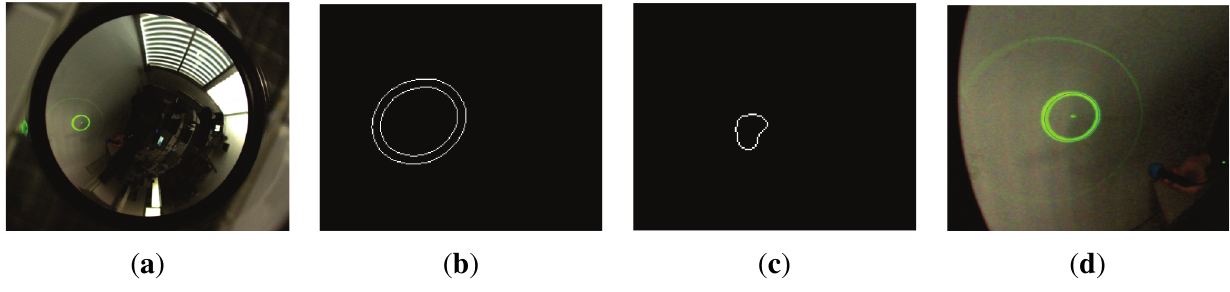
Table 2. Distance estimated using our flexible structured light